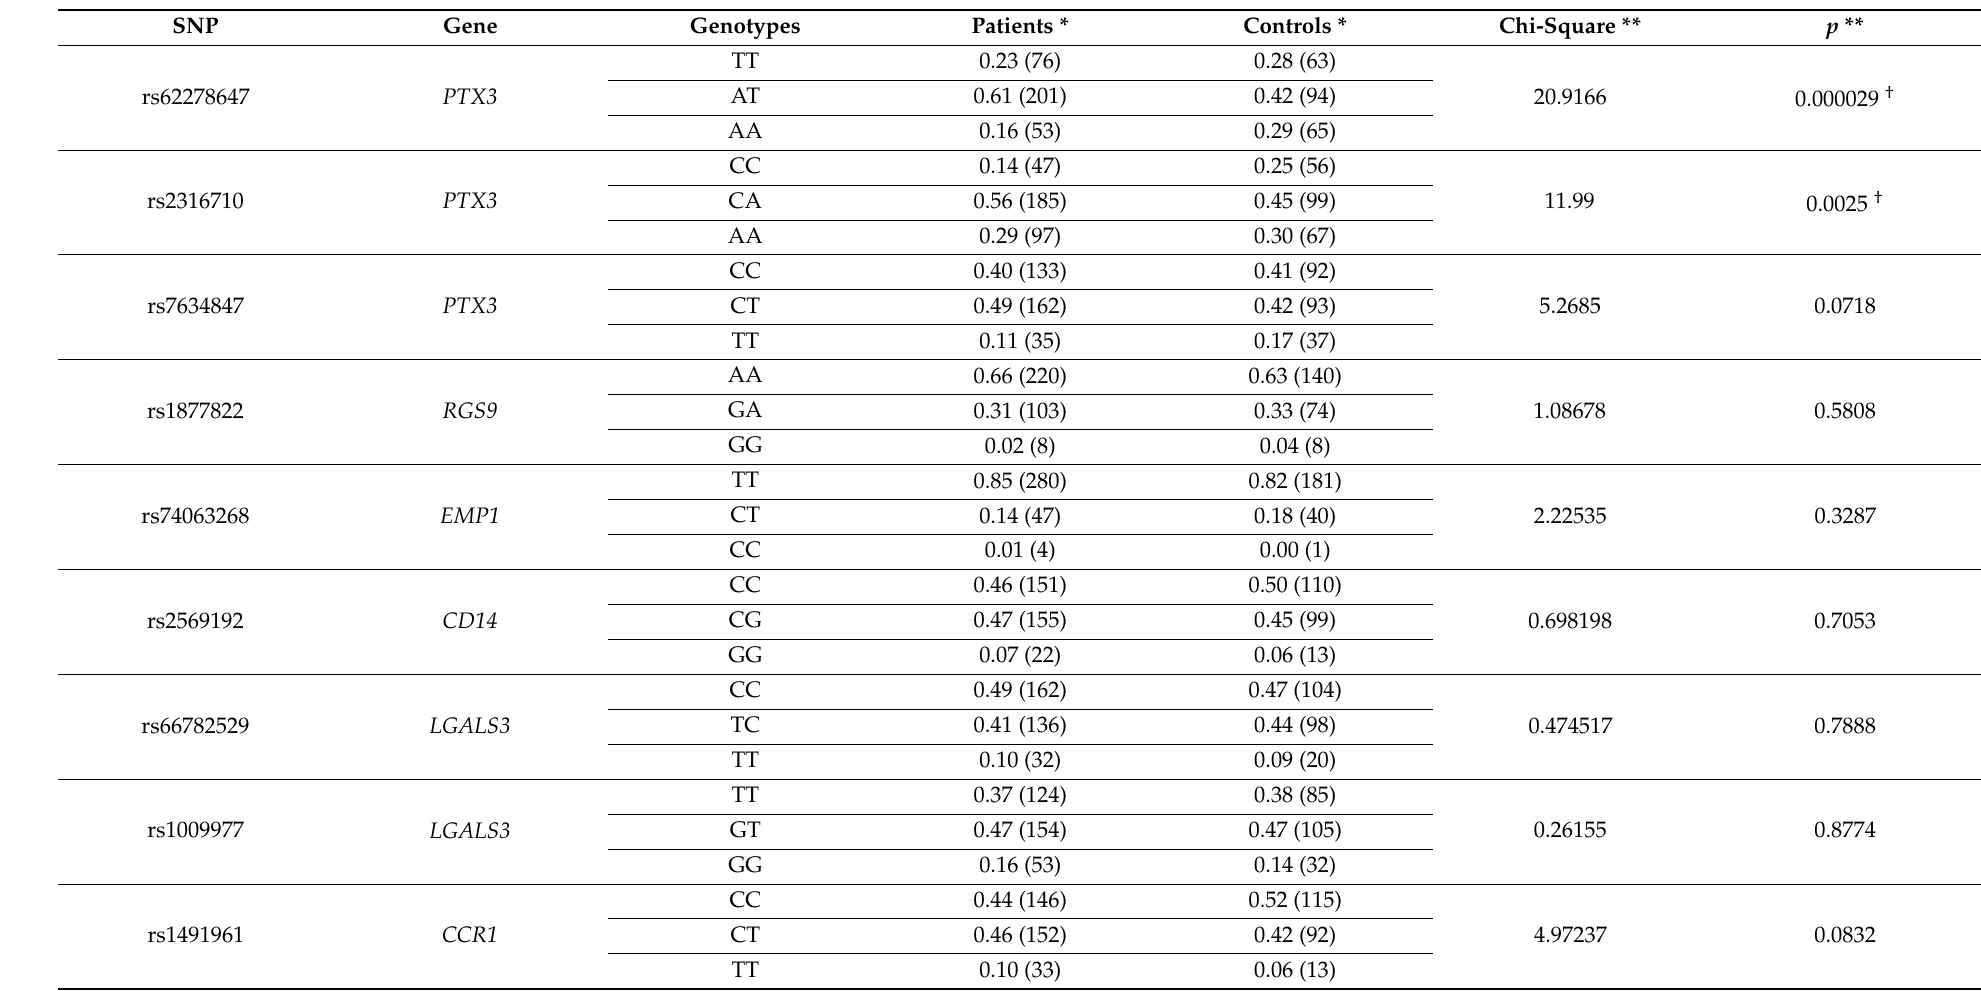
Table 3. Frequency of genotypes in the groups of patients and